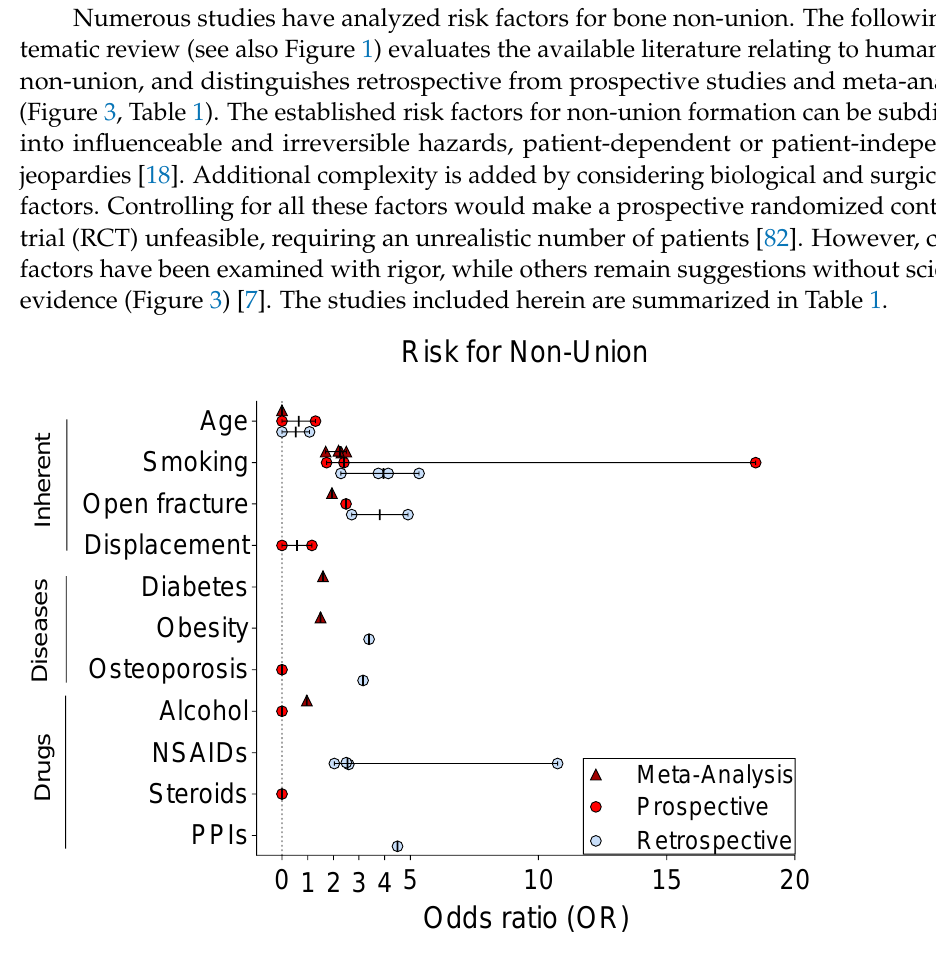
Figure 3. Risk factors for bone non-union formation. The plethora of studies on risk factors eliciting bone non-union makes comparison difficult. Many clinical studies focusing on factors associated with bone healing and related prohibitive diseases have reported that smoking had a harmful effect on bone healing. All study types indicate increased risk of non-union in open fractures. However, for non-steroidal anti-inflammatory drugs (NSAIDs) and proton pump inhibitors (PPI) only a few retrospective studies indicate an elevated risk of non-union. Table 1. Studies analyzing the effect of different factors on bone